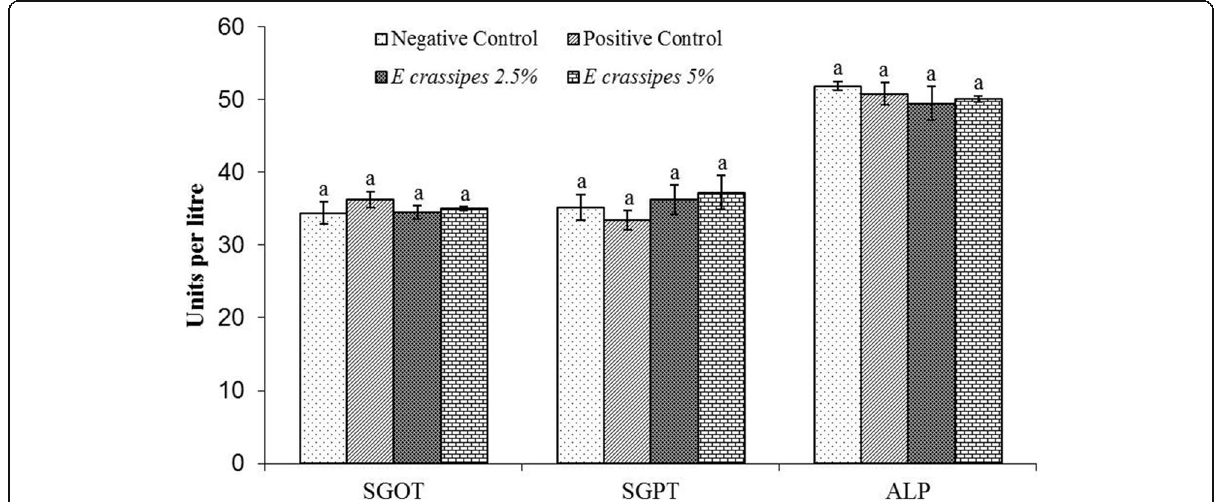
Fig. 2 AST, ALT, and ALP levels in the serum of various groups of Channa punctata: negative control, positive control, and experimental groups (2.5 and 5% feed, respectively). Values are expressed in mean ± SEM. p value was calculated by Student t test ( p ≤ 0.05). Error bars with superscript “ a ” represents that there was no statistical difference in levels among various